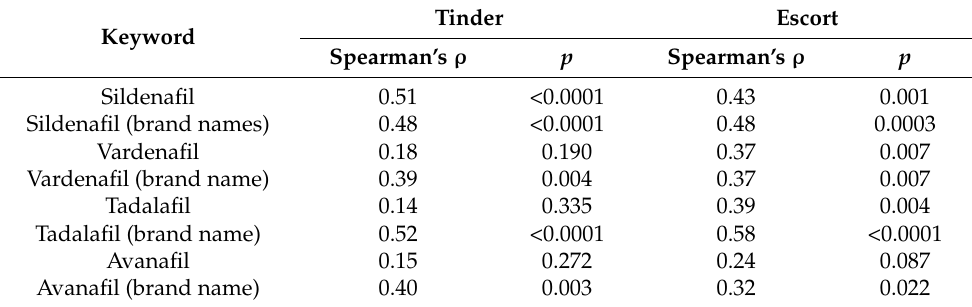
Figure 2. Changes in Google Trends relative search volume for three different keywords (Pornhub, escort, and Tinder) mostly pertaining to male heterosexual behaviors. Table 1. Correlation analysis of keywords pertaining to sexual behaviors and sexual health.